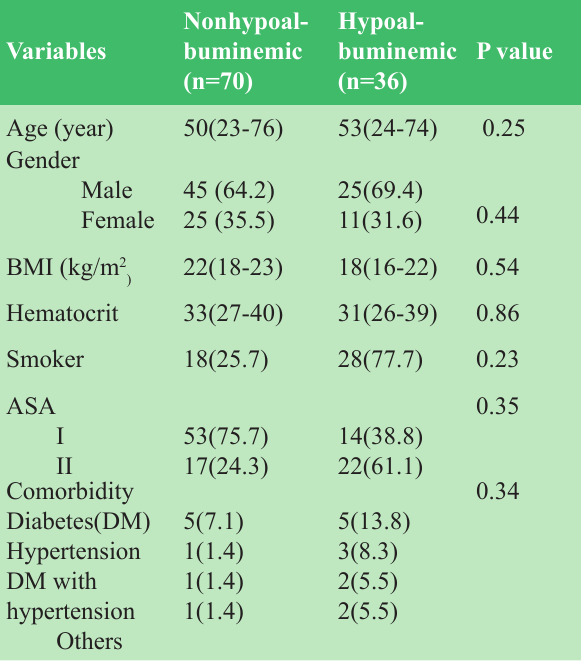
Table 1: Preoperative